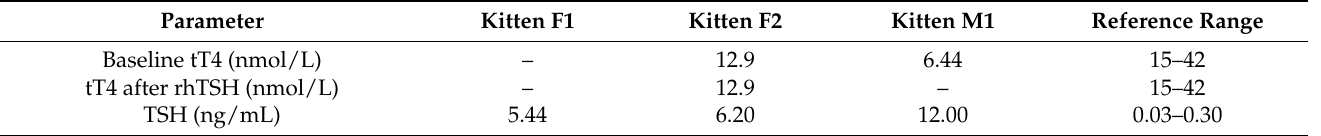
Table 1. Serum tT4 and TSH concentrations, and TSH stimulation test results (0 h and 6 h) at